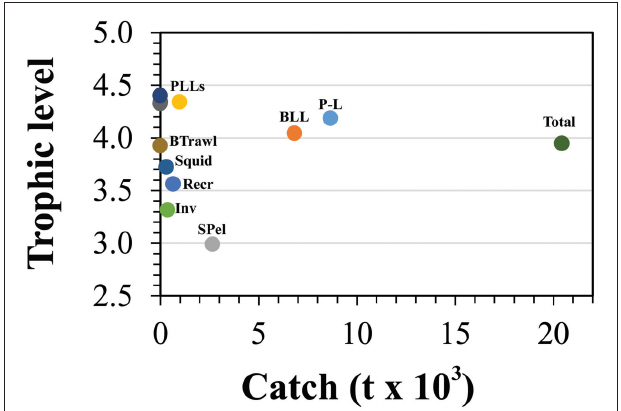
FIGURE 6 | Mean trophic levels of the catch for all fishing fleets included in the Azores ecosystem model for the reference year 1997. BLL is deep-water bottom longline and handline fisheries, P-L refers to the pole and line tuna fishery (including the live-bait catch), SPel refers to the small-size pelagic fisheries, PLLs refers to all pelagic longline fisheries, Recr is the recreational fishing, Inv is the commercial coastal invertebrates fisheries, Squid is the squid ( L. forbesii ) fisheries, and BTrawl is the bottom trawling experimental